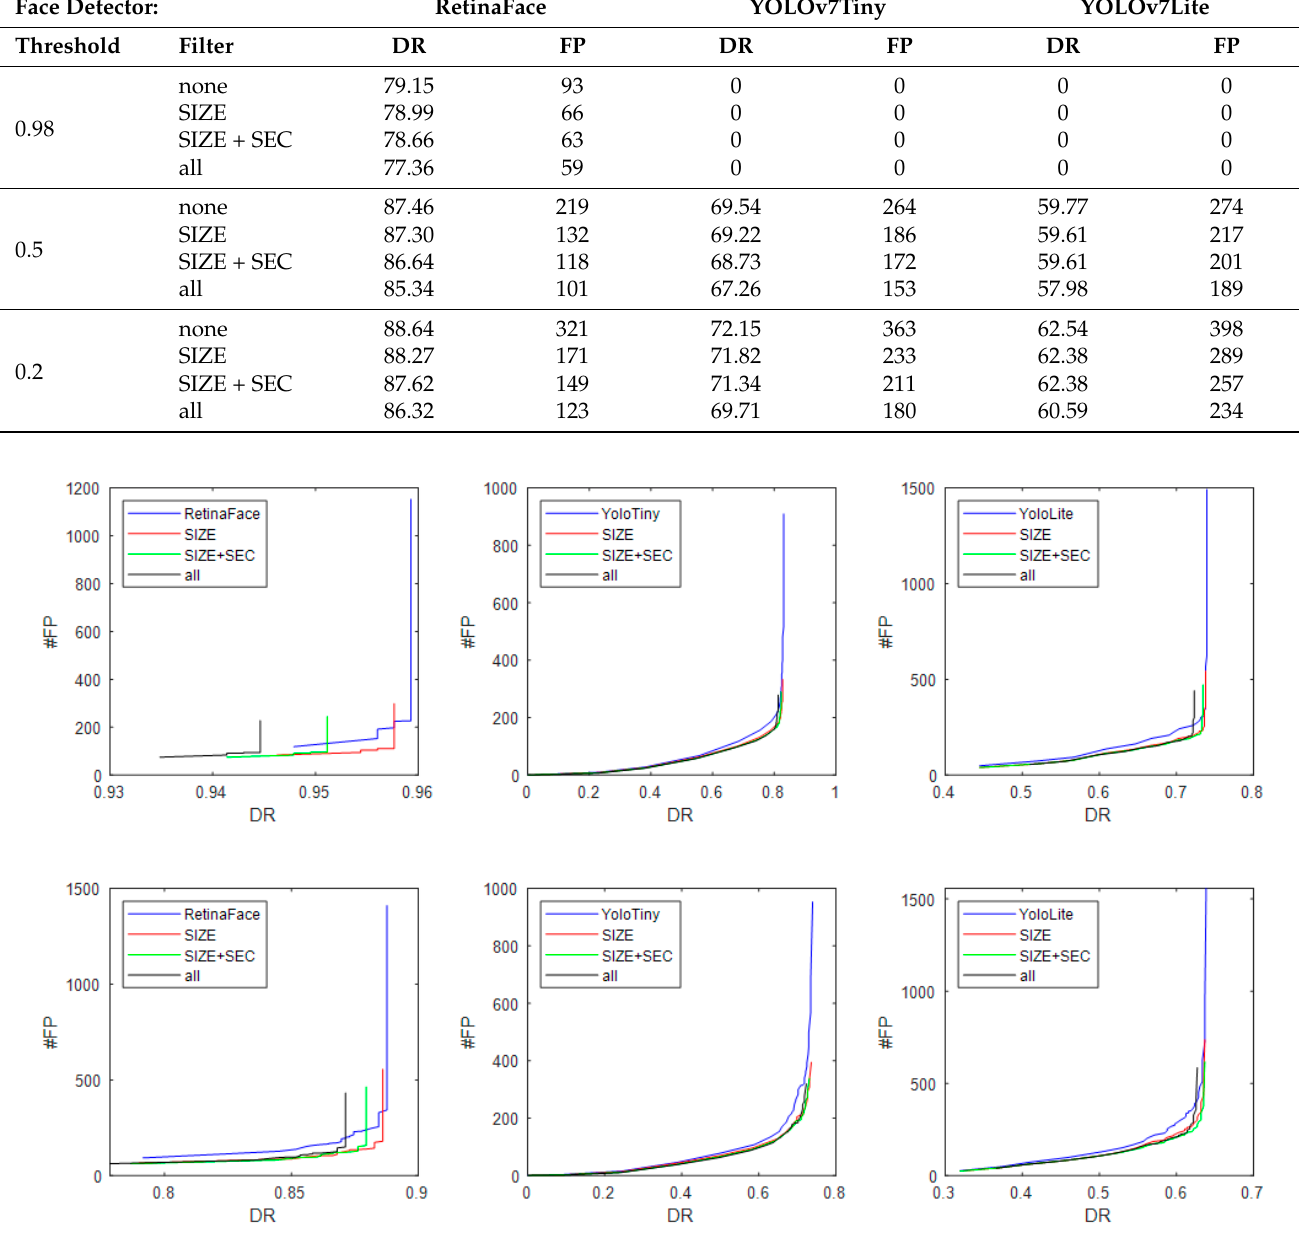
Figure 7. Plot of the detection rate vs. number of false positives for the 3 face detectors (RetinaFace, YOLOv7Tiny, YOLOv7Lite). First row: original dataset, second row: fog-perturbed dataset.